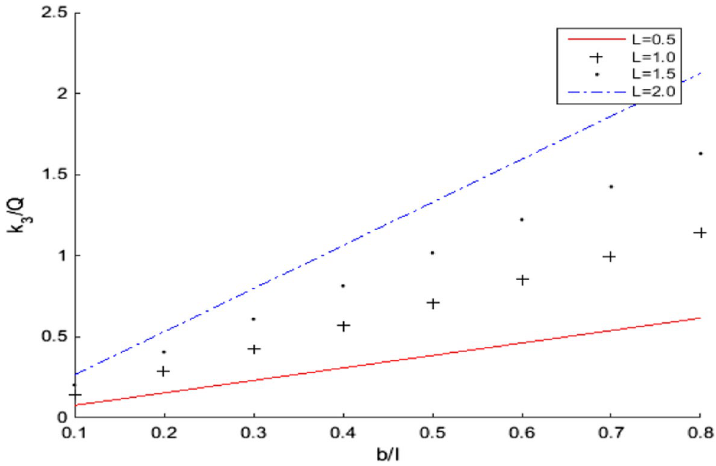
Fig. 4 Variation of k 111 Q with b